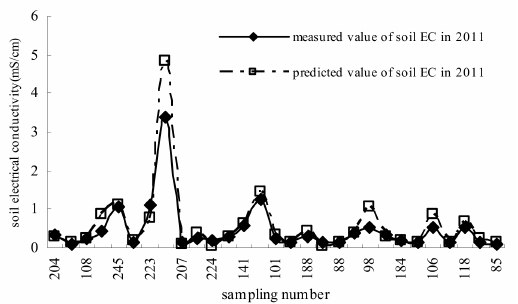
Figure 4. Comparison of predicted and measured value in October 2011.